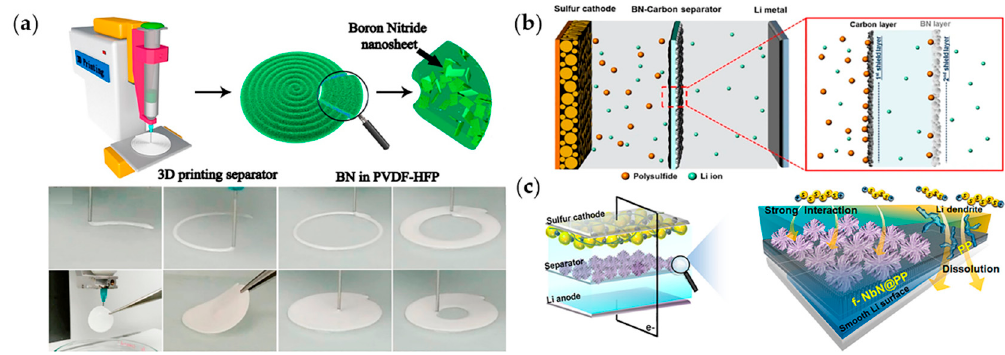
Figure 6. ( a ) Schematic of the 3D printing apparatus, the BN in the PVDF-HFP separator, and the corresponding composition, and digital photographs at different points in the printing process.